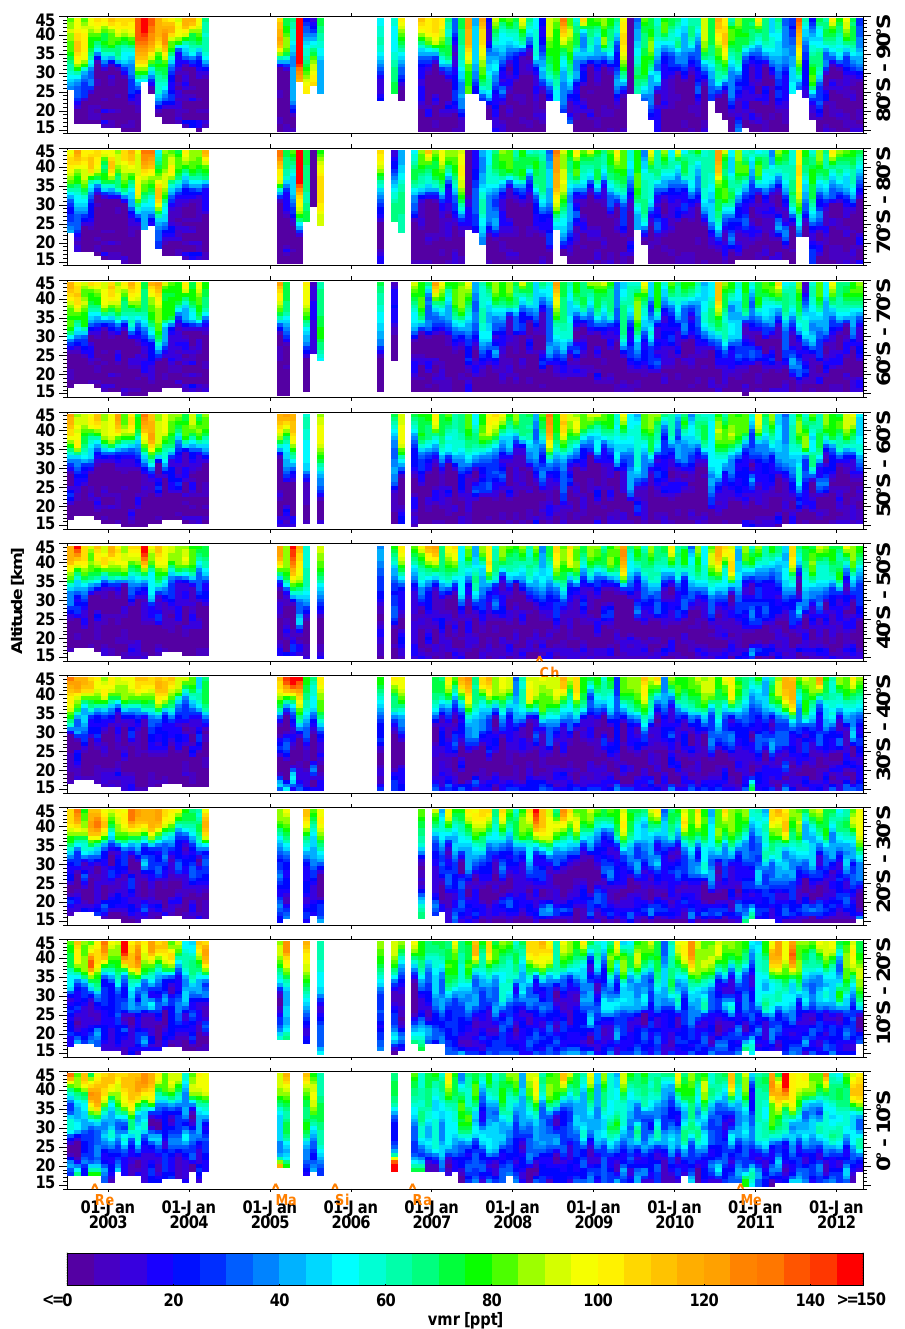
Fig. 4. Time series of colour-coded SO 2 monthly mean volume mixing ratio profiles for 10 ◦ latitude bins in the Southern Hemisphere. The colour scale is restricted to 0–150pptv: negative values and those larger than 150pptv are given the colour corresponding to 0 and 150pptv, respectively. Major volcanic eruptions are indicated within the latitude bin of their location (see Table